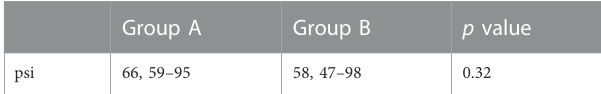
TABLE 3 Peak injection pressure (psi) of two